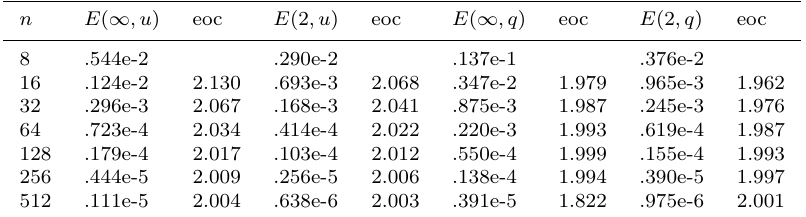
Table 4. Errors and orders of convergence of the P 1 − collocation on the polygonal boundary